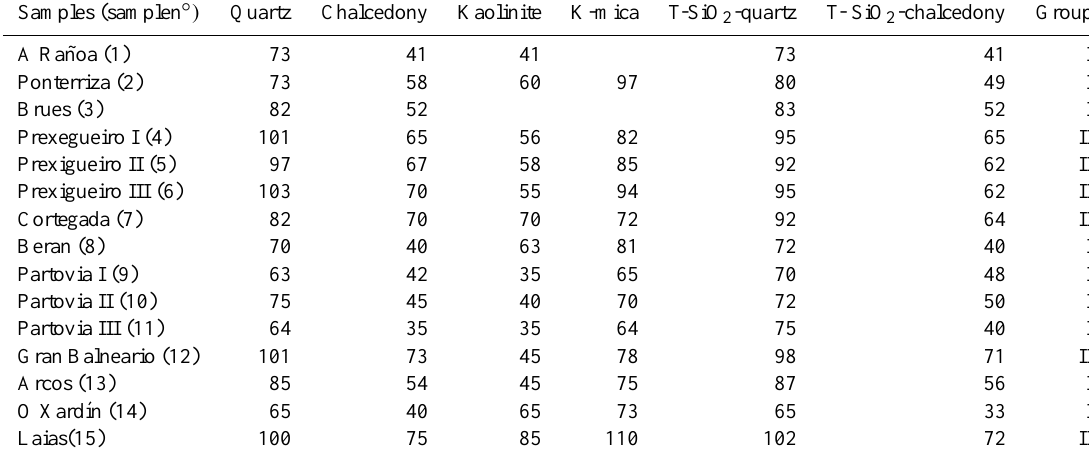
Table 3. Quartz, chalcedony, kaolinite and k-mika equilibrium temperatures ( ◦ C) using the thermodynamic database (Ball and Nordstrom, 2001). Equilibrium temperatures ( T ) for the geothermometers of SiO 2 -quartz and chalcedony are also shown. Samples (samplen ◦ )